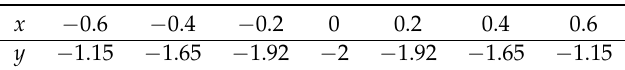
Table 4. Convex set of